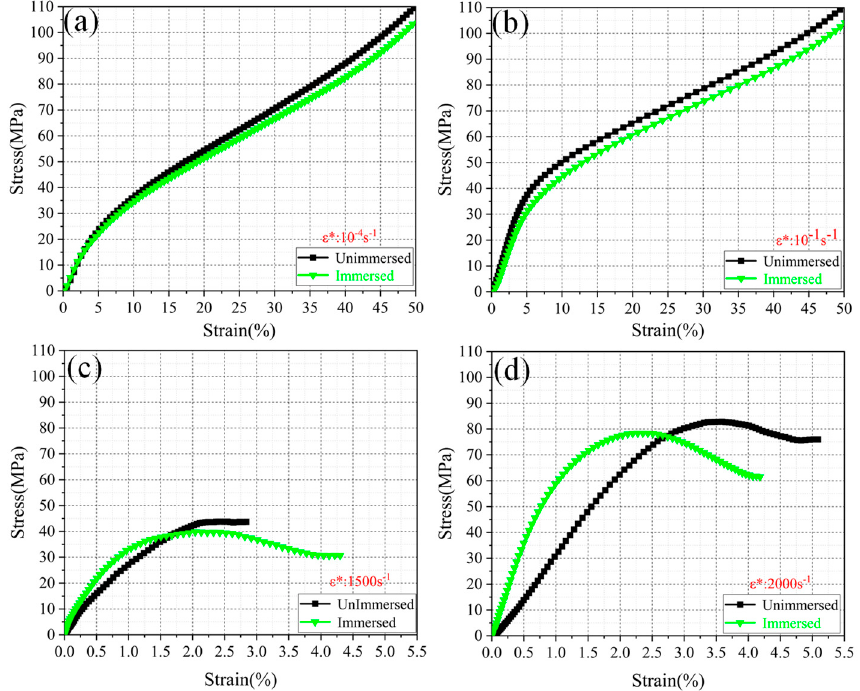
Figure 8. The stress–strain curves of SLS of PA12 under different strain rates: ( a ) 10 -4 s -1 ; ( b ) 10 -1 s -1 ; ( c ) 1500 s -1 ; ( d ) 2000 s -1 .